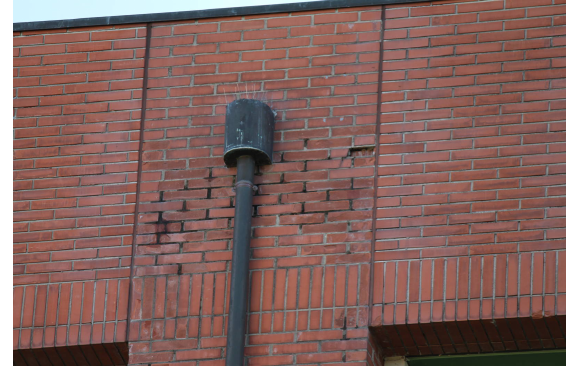
Figure 7. Histogram of point-to-plane distances for damaged brick shown in Fig. 5(b).